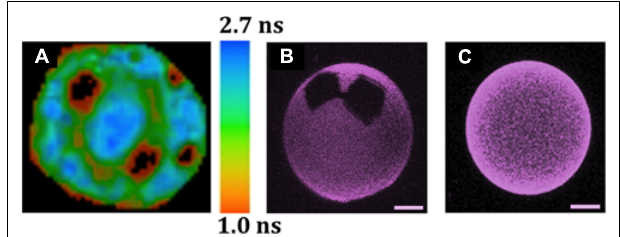
FIGURE 2 | Observation by different fluorescence microscopic techniques of lipid domain organization in GUVs and of the solubilizing properties of cholesterol. The GUVs were all labeled with Rho-DOPE (0.2 mol%), which partitions preferentially into Ld over Lo phases, and is excluded from So domains. (A) Coexistence of three lipid phases (Ld/Lo/So) in one single GUV, as detected by FLIM after two-photon excitation (de Almeida etal., 2007).The image corresponds to the top view of a ternary GUV DOPC/DPPC/cholesterol 11:11:3 mol:mol:mol at 24 ◦ C.The 3 phases were identified by combining the data from fluorescence intensity and lifetimes. So (black areas), Lo: intermediate intensity and mean lifetime of ∼ 1.7 ns (green areas), Ld: higher intensity and mean lifetime of ∼ 2.5 ns (blue areas).The sidebar provides the fluorescence lifetime color code. (B,C) The presence of 12% of N -palmitoylceramide (PCer) results in the formation of gels domains, even with 10% cholesterol, but such domains are not seen at 40% cholesterol, even when the amount of PCer is raised to 20 mol% (Castro etal., 2009).The precise GUV compositions are (B) POPC/cholesterol (9:1) with 12 mol% PCer and (C) POPC/cholesterol (3:2) with 20 mol% PCer.The images are 3D projections obtained from confocal sections of GUVs at 22 ◦ C (scale bar: 5 μ